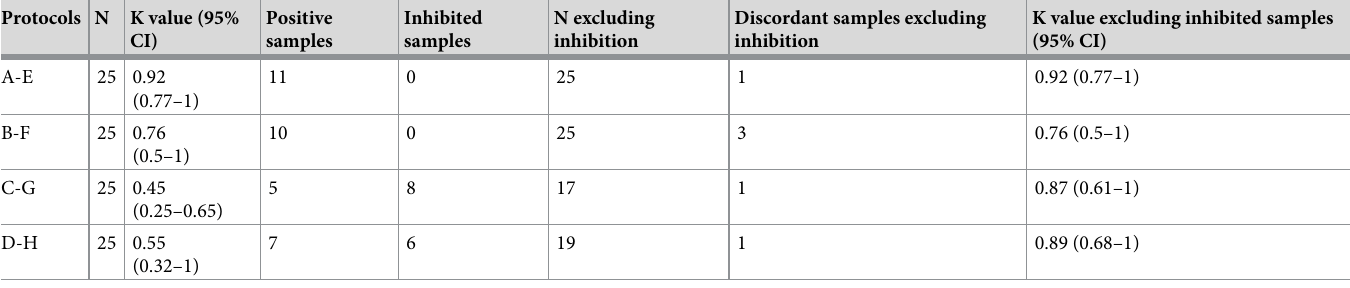
Table 5. Cohen’s kappa coefficient (K) results for the comparison between protocols with the sample treatment as the only variable. K values are shown including and excluding inhibited samples. Protocols N K value (95% CI)